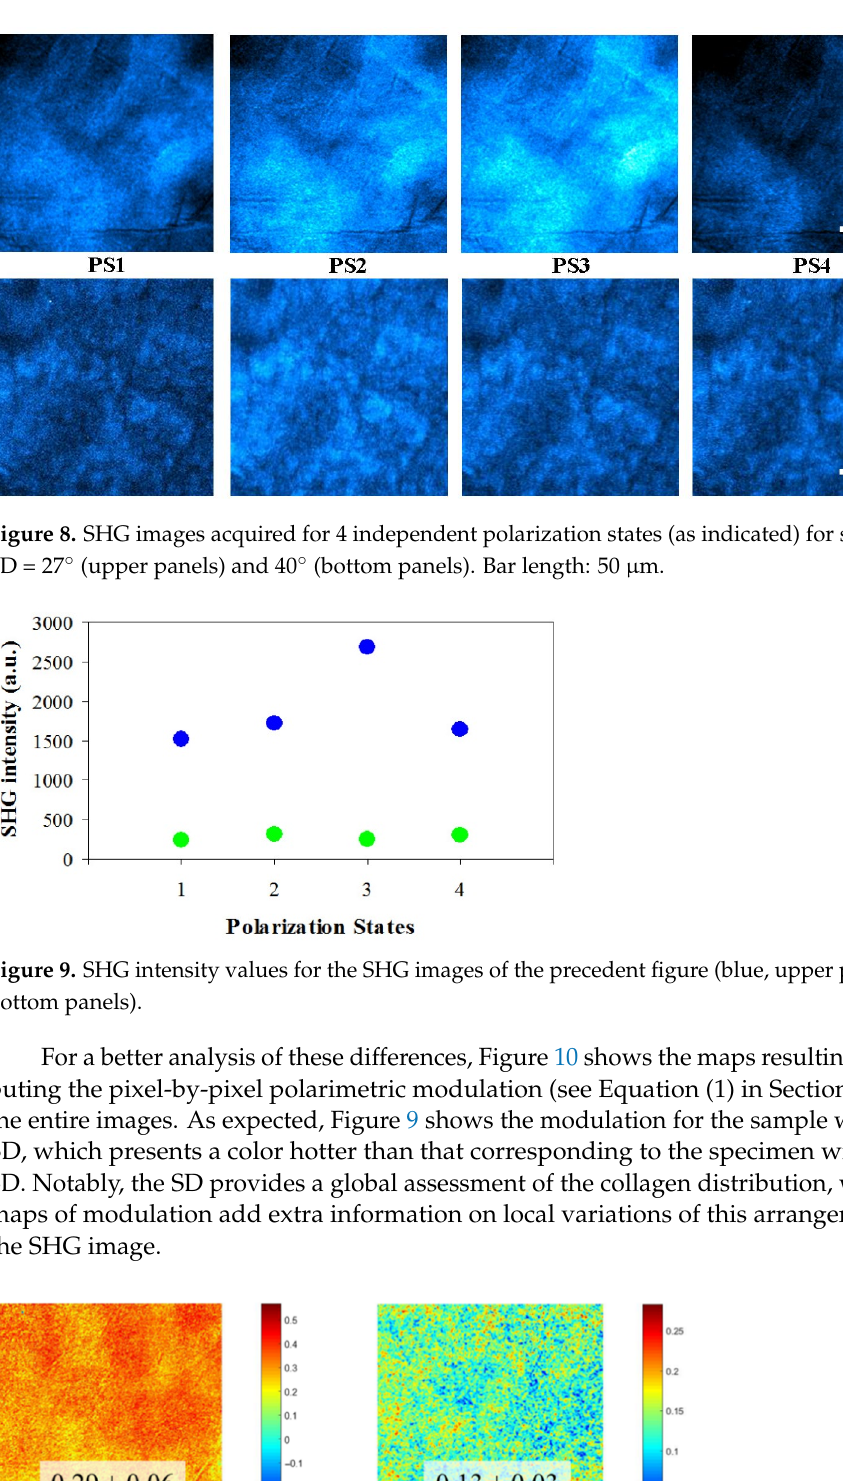
Figure 10. Spatially resolved maps of polarimetric modulation computed from the SHG images in Figure 8. The values in the insets are the averaged values across each map, with the corresponding standard deviation.